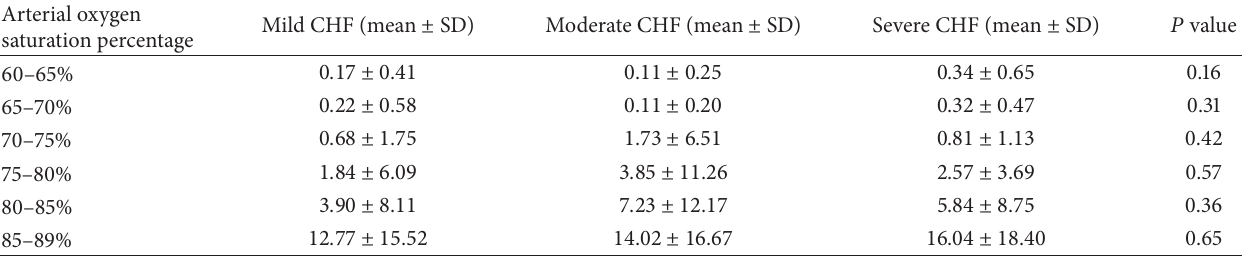
Table 2: Correlation between the two variables of arterial oxygen saturation percentage and ejection fraction in study patients. Arterial